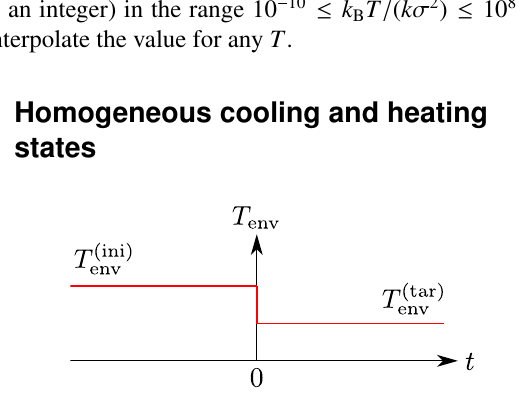
Figure 2. Schematic of the protocol. The environmental temper- ature is set as T env = T (ini) env for t < 0, and is changed to T env = T (tar) env at t = 0. Here, the case for T (ini) env > T (tar) env is shown.